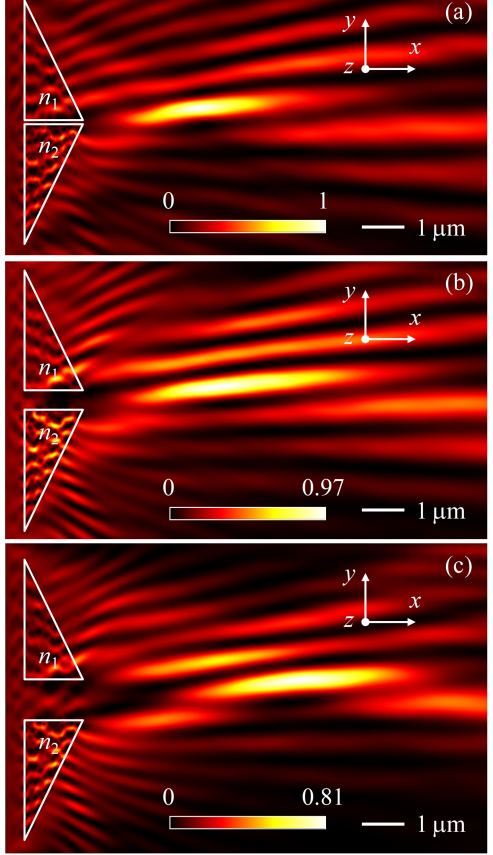
Figure 6. Normalized intensity distributions of the photonic hooks formed by triangular Janus micro-prisms at ( a ) d = 100 nm, ( b ) d = 500 nm, and ( c ) d = 1000 nm. The refractive indices of triangular Janus micro-prisms are n 1 = 1.5 and n 2 = 1.88.